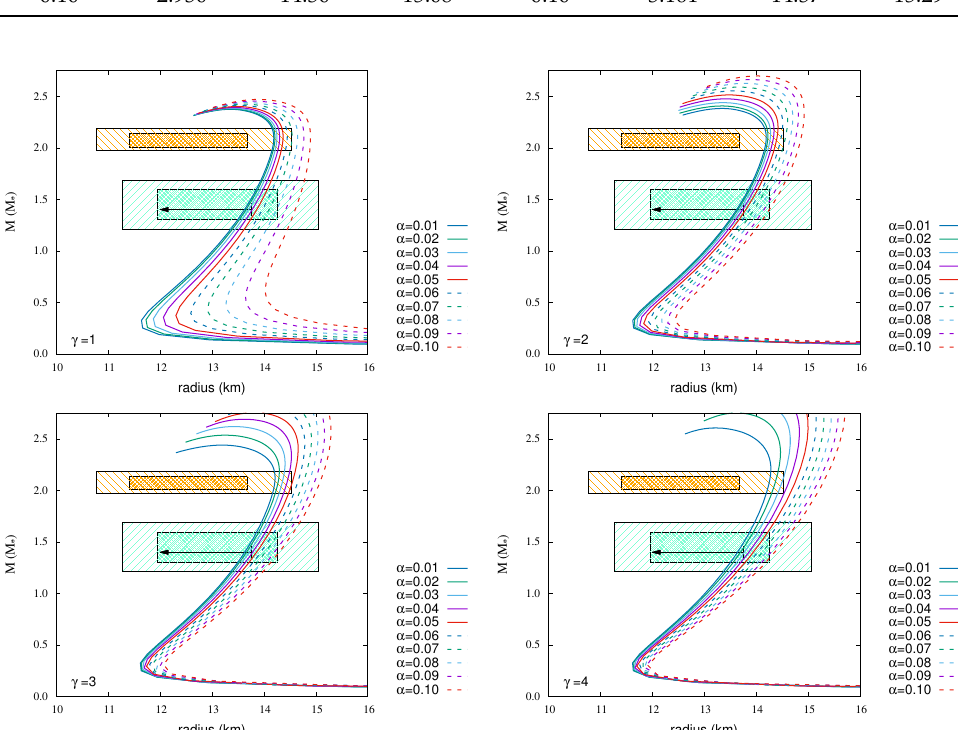
Figure 7. MR relations of NL3 ωρ -b EoS with magnetic fields. The strength of surface magnetic field strength B s is 10 12 G, and the central magnetic field strength B 0 is 2.5 × 10 18 G. The arrow and colored hatched areas are the same as in Figure